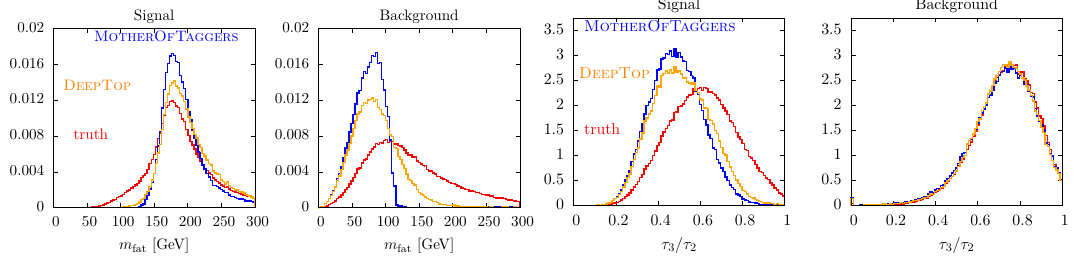
Figure 9 . Kinematics observables m fat and (cid:28) 3 =(cid:28) 2 for events correctly determined to be signal or background by the DeepTop neural network and by the MotherOfTaggers BDT, as well as Monte Carlo